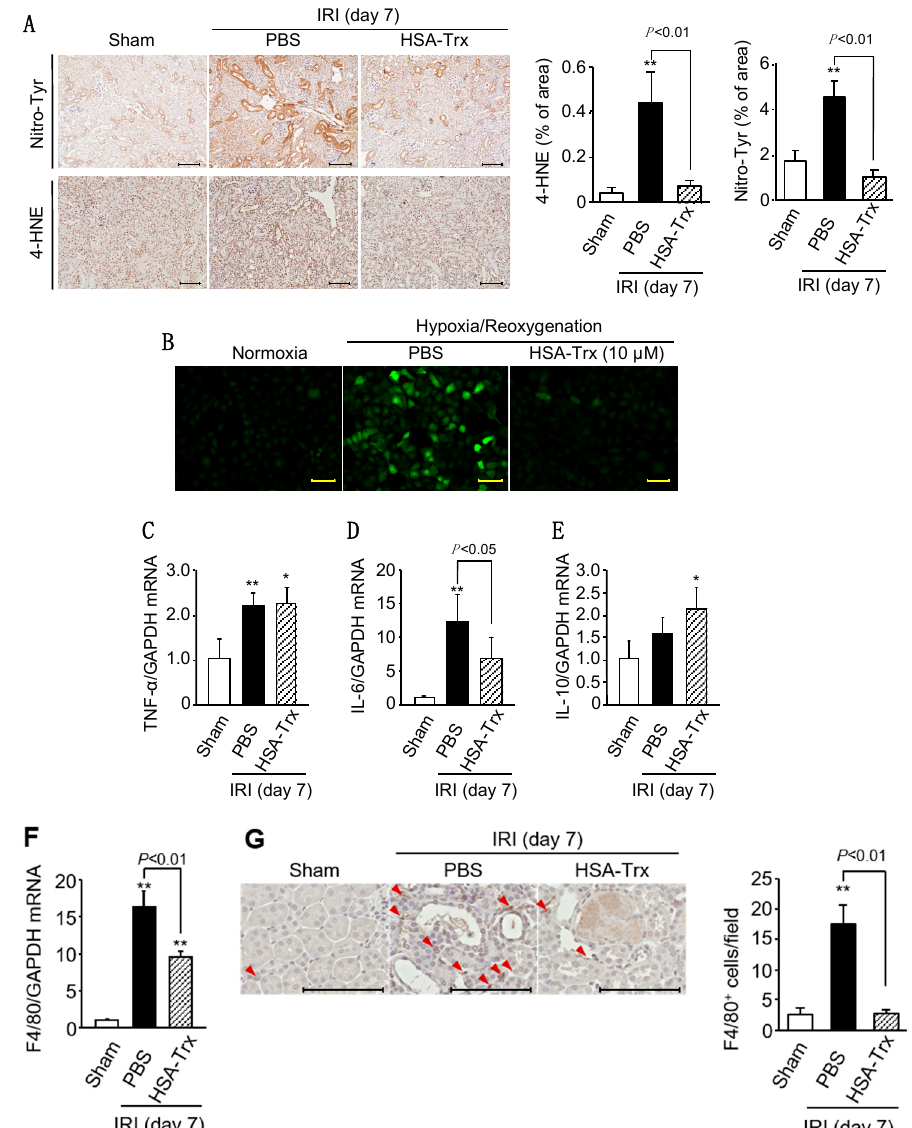
Figure 3. Effect of HSA-Trx on renal oxidative stress and inflammation. ( A ) Effect of HSA-Trx on renal oxidative stress in renal IR-treated mice on 7 days after renal IR: Representative photomicrographs and quantification of immunostaining of renal Nitro-Tyr (nitrotyrosine) and 4-HNE (4-hydroxynonenal) are shown on 7 days after renal IR. Original magnifications: × 200. Scale bars represent 100 µ m. ( B ) Effect of HSA-Trx on cellular ROS level in hypoxia/reoxygenation-treated HK-2 cell: Cellular ROS level in HK-2 cells was detected by CM-H 2 DCFDA, an ROS-sensitive fluorescent dye. HK-2 cells were exposed to 0.1% O 2 hypoxia (Anaeropack ® : Mitsubishi Gas Chemical Co. Inc., Tokyo, Japan) for 24 hr in the presence or absence of 10 µ M HSA-Trx, followed by reoxygenation, and the HK-2 cells were then incubated with CM-H 2 DCFCA for 30 min. After the reaction, cells were observed using a microscope. Original magnifications: × 200. Scale bars represent 100 µ m. Effect of HSA-Trx on cytokine expression and macrophage infiltration in the kidneys of renal IR-treated mice on 7 days after renal IR: mRNA expression of ( C ) TNF- α , ( D ) IL-6, ( E ) IL-10 and ( F ) F4/80 in kidney on 7 days after renal IR were determined by real-time PCR. ( G ) Representative photomicrographs and quantification of immunostaining of renal F4/80 are shown on 7 days after renal IR. F4/80-positive cells are indicated by arrowheads. Original magnifications: × 800. Scale bars represent 100 µ m. Data are expressed as means ± SD ( n = 5). * p < 0.05, ** p < 0.01 compared with sham